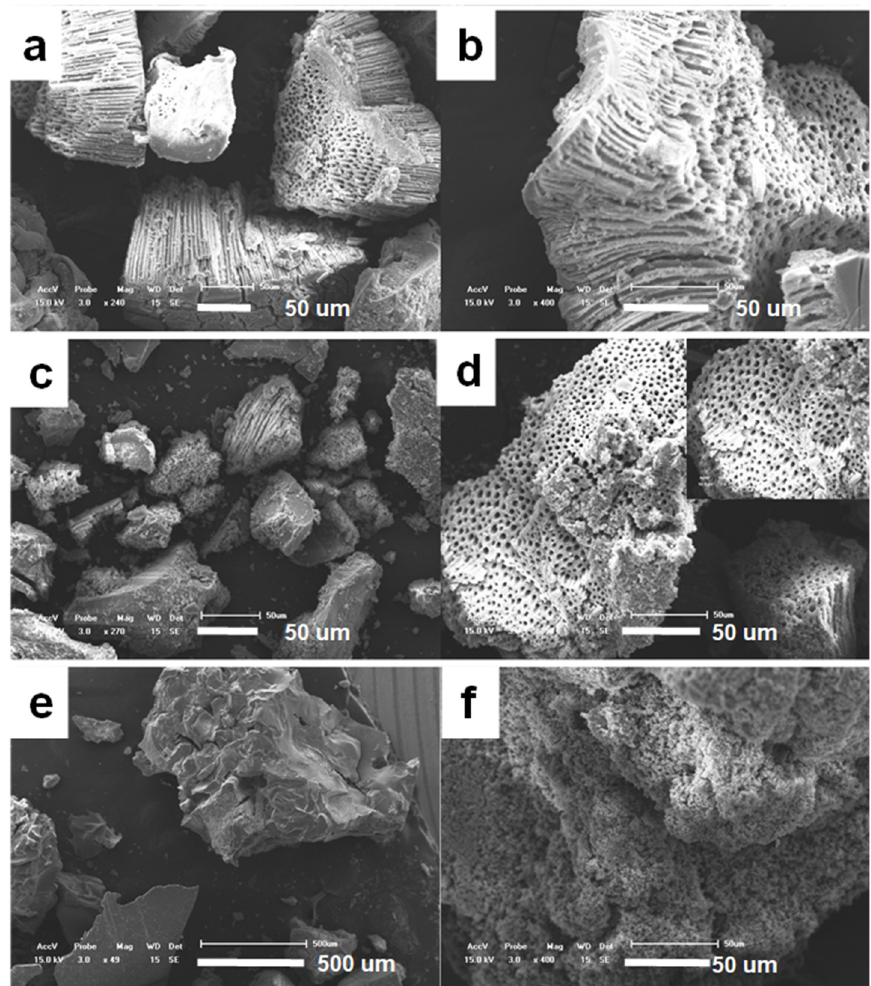
Figure 5. SEM images of titanium precursors prepared by the addition of citric acid. ( a , b ) 0.72 g, ( c , d ) 1.8 g, ( e , f ) 3.59 g. ( c , d ) 1.8 g, ( e , f ) 3.59